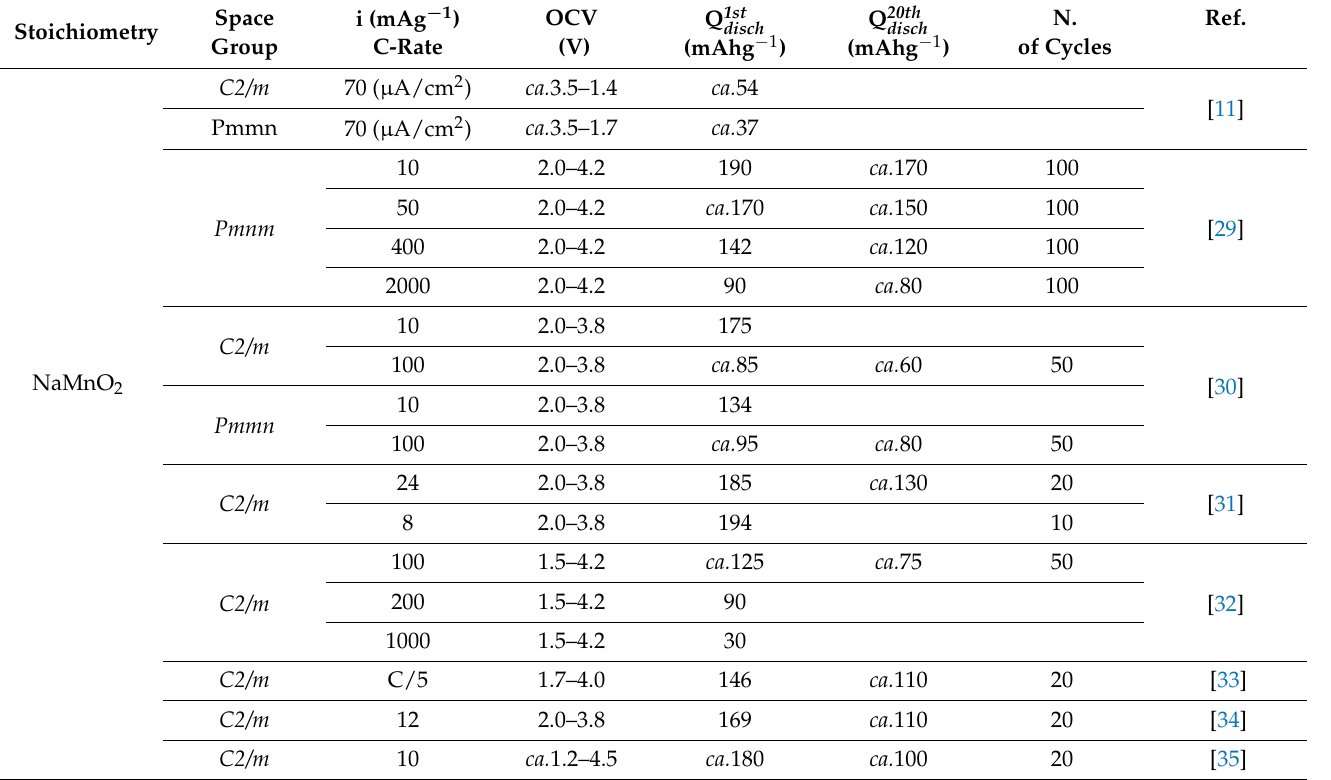
Table 1. Results from studies about O3-type NaMnO 2 (and its orthorhombic distorted equivalent) used as cathode in SIBs